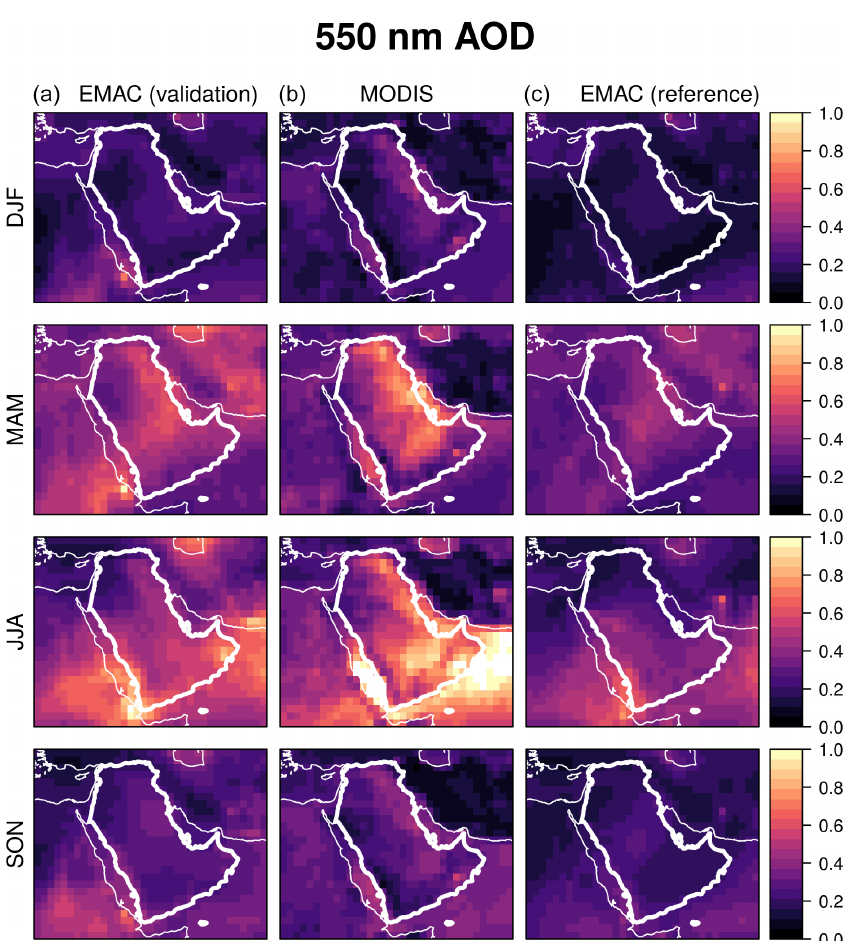
Figure 12. Seasonal 550nm AOD over the Middle East in 2011 observed by MODIS (b) and simulated by EMAC with (“validation”, a ) and without (“reference”, c ) revision of the dust emission scheme. Each row shows the 3-month averages over the periods (from top to bottom) DJF (December, January, February), MAM (March, April, May), JJA (June, July, August) and SON (September, October, November). Especially throughout the white-bounded region encompassing the Arabian Peninsula including Iraq, Syria and Jordan, the AOD distribution obtained with the revised dust emissions agrees significantly better with the MODIS observations (see Fig. S6 in the